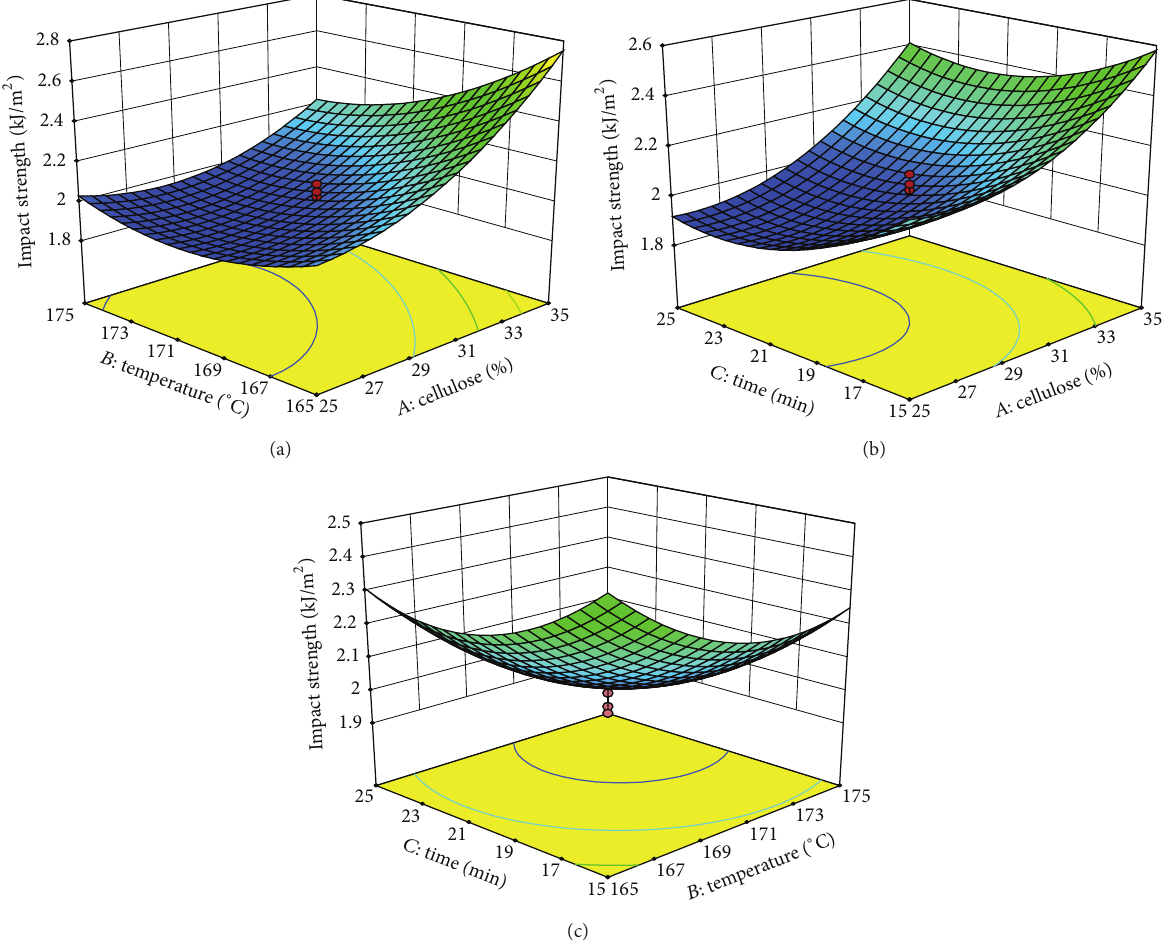
Figure 5: Response surface plots of the combined effects of the independent variables on impact strength of biocomposites.